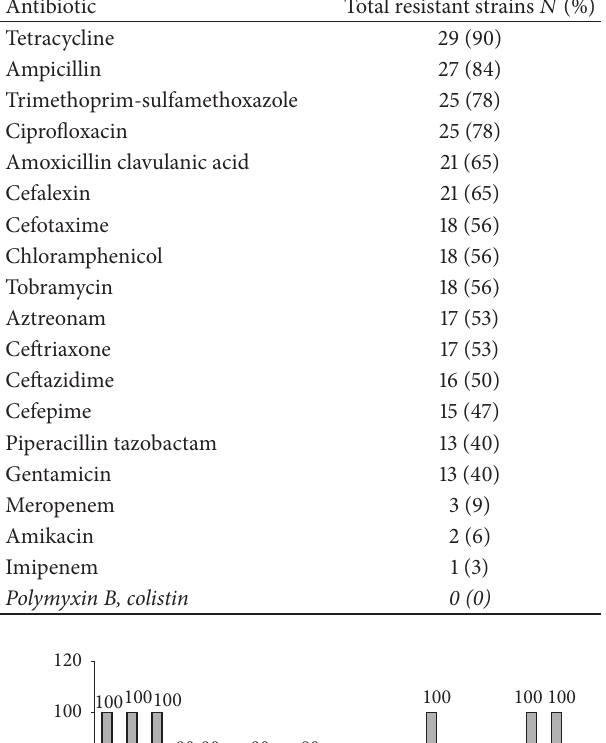
Table 3: Antibiotic resistance patterns of Enterobacteriaceae (32) strains isolated from diabetic foot patients.